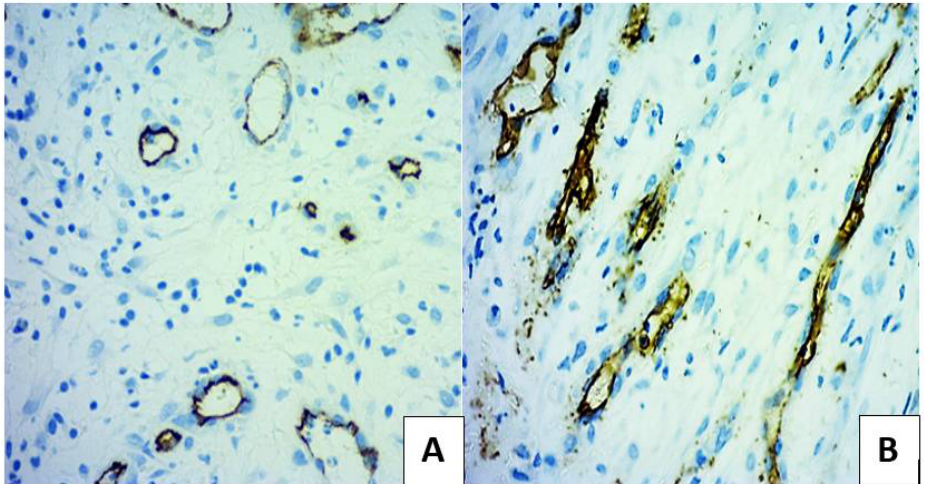
Figure 3. Immunostaining with CD34 in ulcer bed for measuring vessels at 14 days of treatment. Fields selected from the most vascularised sectors, from patients with SuDe ( A ) and with SuDe + Lp ( B ) treatment. Photos were taken with 20× objective.